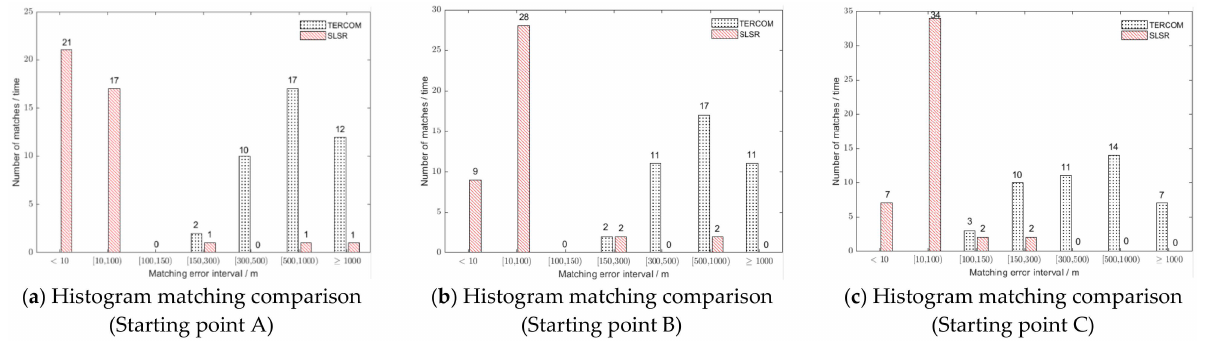
Figure 9. Histogram comparison of error statistics of out-of-region matching points at different tracking starting